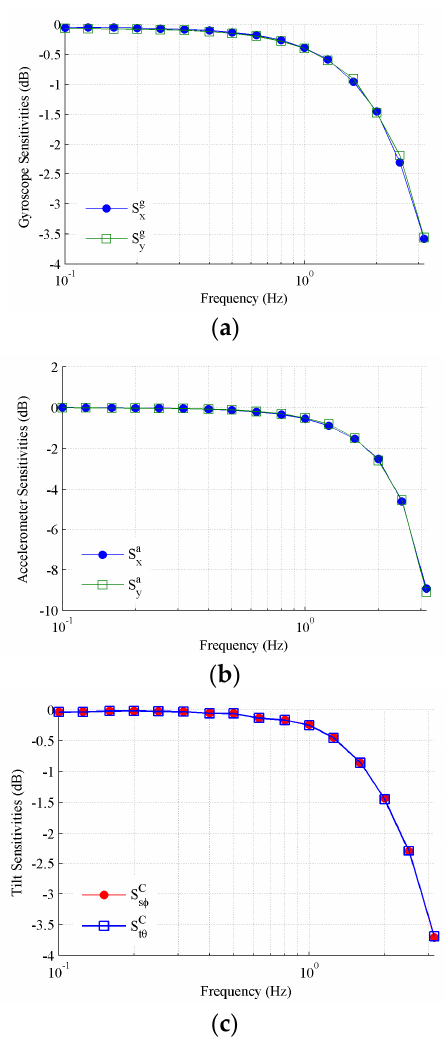
Figure 9. Amplitude frequency curves. ( a ) Accelerometer; ( b ) gyroscope; ( c ) tilt sensing.